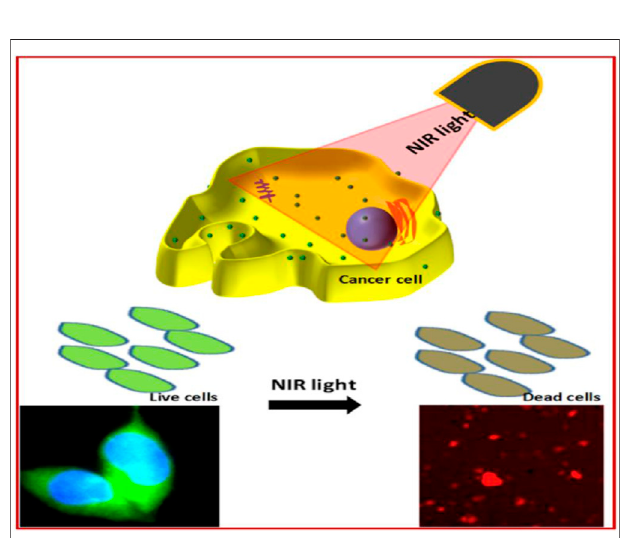
FIGURE 8 | Overall presentation of synthesis and application of multifunctional CQDs (nanodots) (BCCGH) from BSA, carbon dots, and metal ions Cu 2 + and Gd 3 + for photoinduced treatment. (Hua et al.,